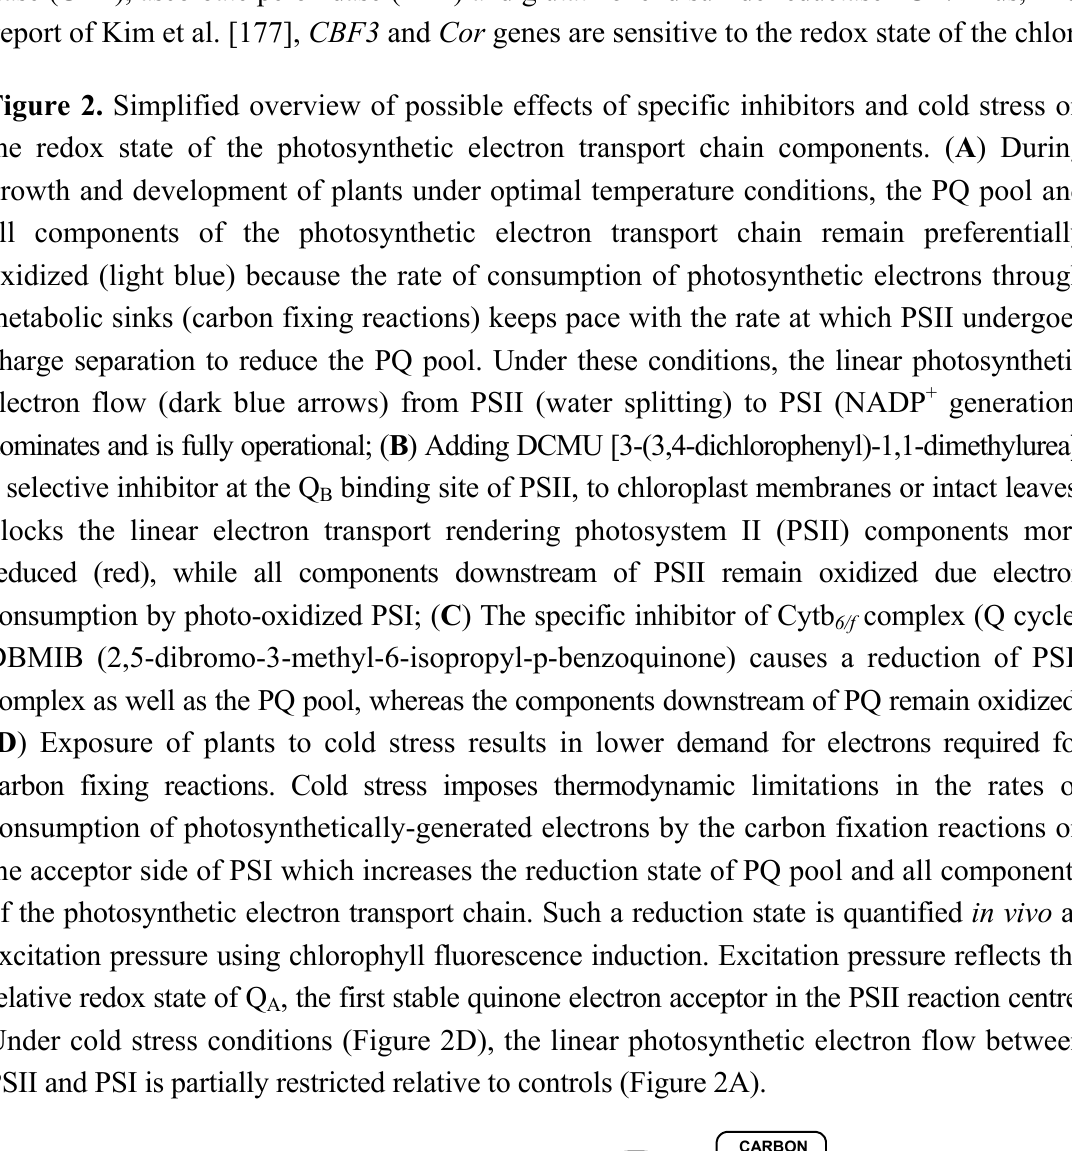
Figure 2. Simplified overview of possible effects of specific inhibitors and cold stress on the redox state of the photosynthetic electron transport chain components. ( A ) During growth and development of plants under optimal temperature conditions, the PQ pool and all components of the photosynthetic electron transport chain remain preferentially oxidized (light blue) because the rate of consumption of photosynthetic electrons through metabolic sinks (carbon fixing reactions) keeps pace with the rate at which PSII undergoes charge separation to reduce the PQ pool. Under these conditions, the linear photosynthetic electron flow (dark blue arrows) from PSII (water splitting) to PSI (NADP +